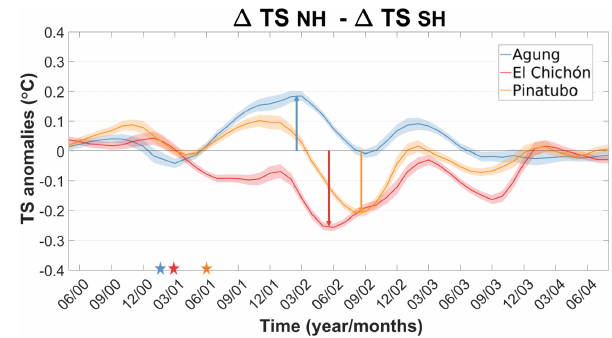
Figure 4. Evolution of the difference in the ensemble mean be- tween the volcanically induced cooling of the SH and the NH after each eruption ( (cid:49)T NH − (cid:49)T SH ). Shading represents twice the stan- dard error of the ensemble mean (i.e. ∼ 95% confidence